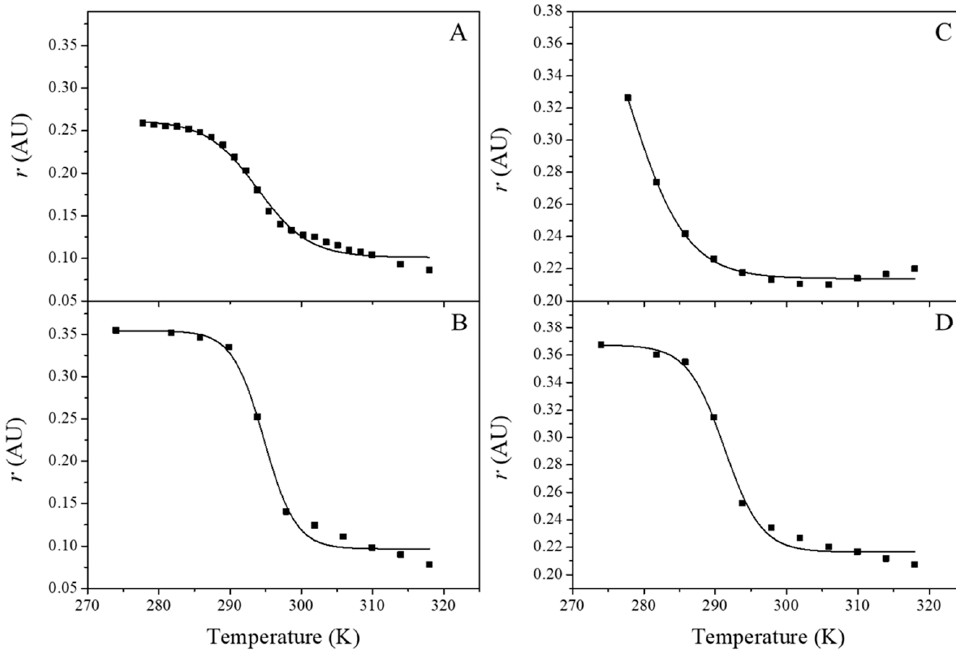
Figure 2. Temperature dependence of the fluorescence anisotropy ( r ) of POPE:POPG (3:1, mol/mol) liposomes incubated with DPH ( A , B ) or TMA-DPH ( C , D ). ( A , C ) Blank liposomes; ( B , D ) liposomes incubated with 5 nM G1OLO-L 2 OL 2 .